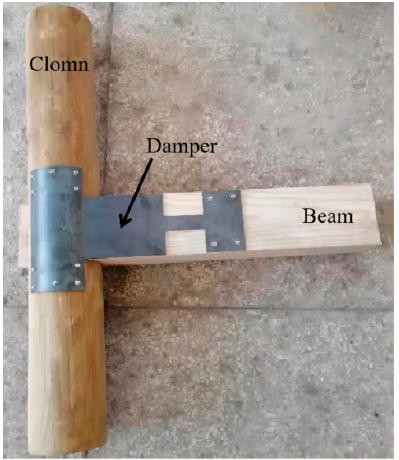
Figure 4. Mounting effect of dampers (unit: mm).